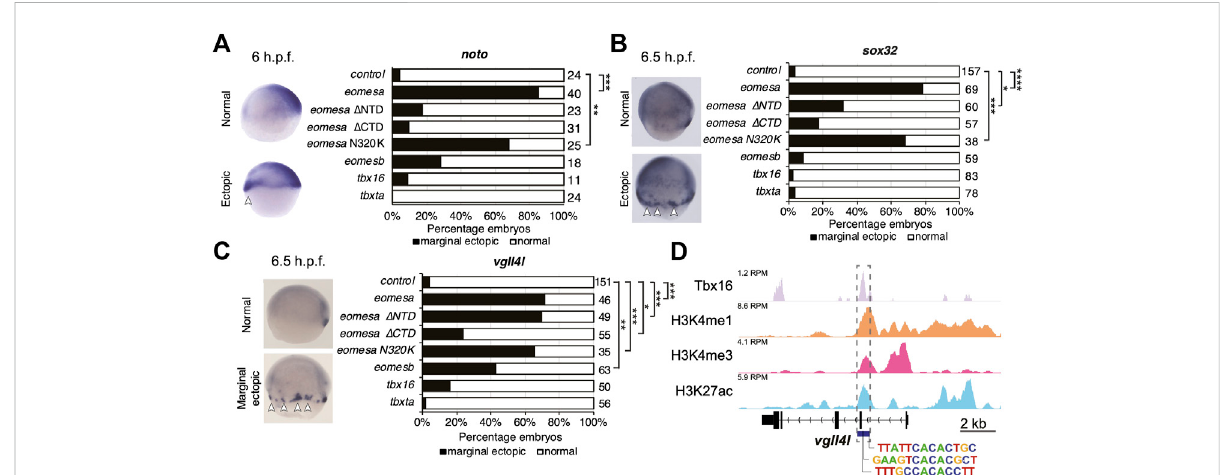
FIGURE 5 Eomesa is a more potent inducer of endoderm, organiser and dorsal forerunner cell markers than other T-box factors. (A – C) WISH analysis of dorsal mesoderm marker noto (A) and dorsal forerunner cell markers sox32 (B) and vgll4l (C) on overexpression of various wild type and mutant T-box factors. mRNAs injected at the1 cell stage; WISH performed at stagesas indicated. N = 2. Total numbers of embryos scored per condition are indicated. Representative images of expression patterns per gene per category are shown. Lateral views; dorsal to the right. Arrowheads indicate ectopic expression. Fisher ’ s Exact two-tailed probability test p values: * P ≤ 5 × 10 − 4 ; ** P ≤ 5 × 10 − 6 ; *** P ≤ 5 × 10 − 12 ; **** P ≤ 5 × 10 − 30 . (D) ChIP-seqdatainmid/lategastrulas(8 – 8.5 h.p.f.)indicating Tbx16bindingwithinthe vgll4l